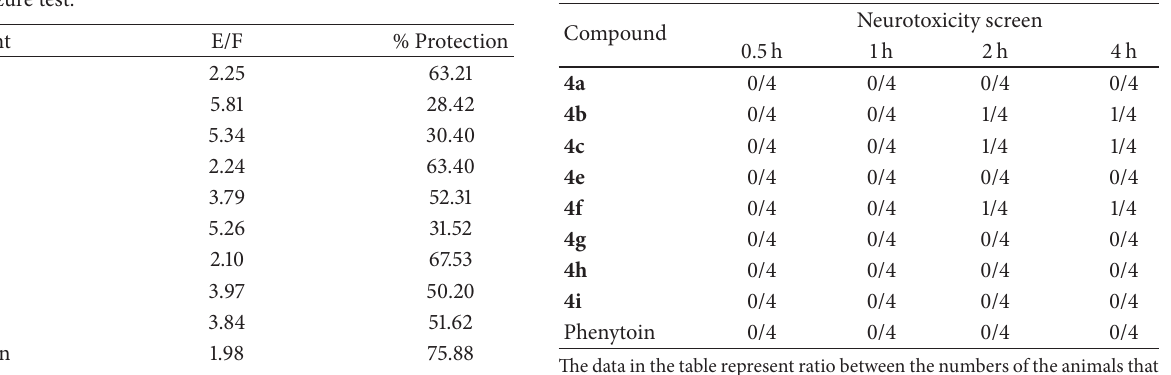
Table 3: Neurotoxicity screening of the compounds 4(a–i)